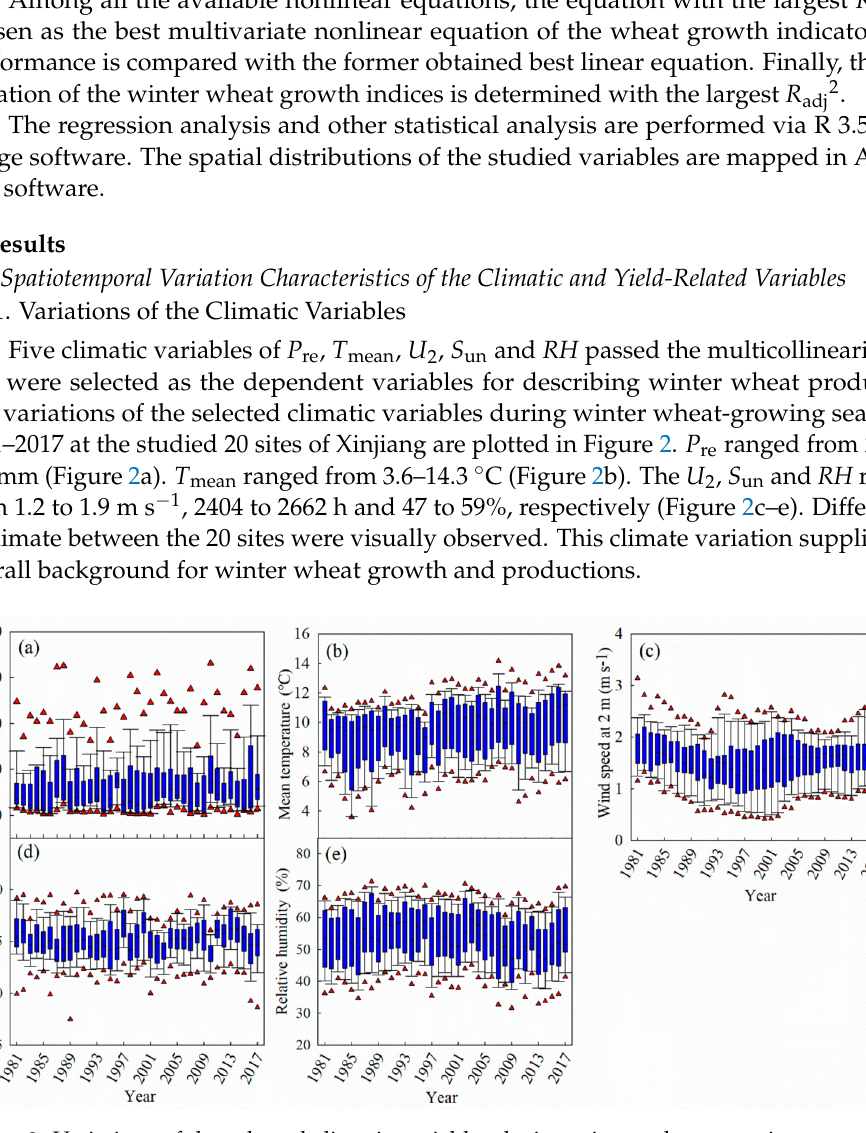
Figure 2. Variations of the selected climatic variables during winter wheat-growing seasons over 1981–2017 at the 20 sites of Xinjiang, China. ( a ) Precipitation, ( b ) Mean temperature, ( c ) Wind speed at 2 m, ( d ) Sunshine hour, and ( e ) Relative humidity. Black horizontal line: median; box-boundaries: 25th and 75th percentiles; whiskers: 10th and 90th percentiles; triangles: